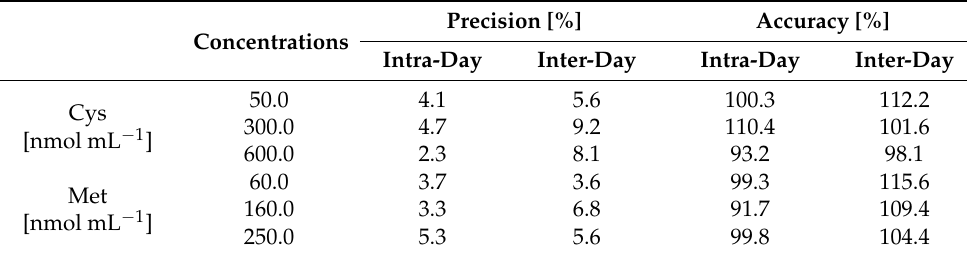
Table 2. Accuracy and